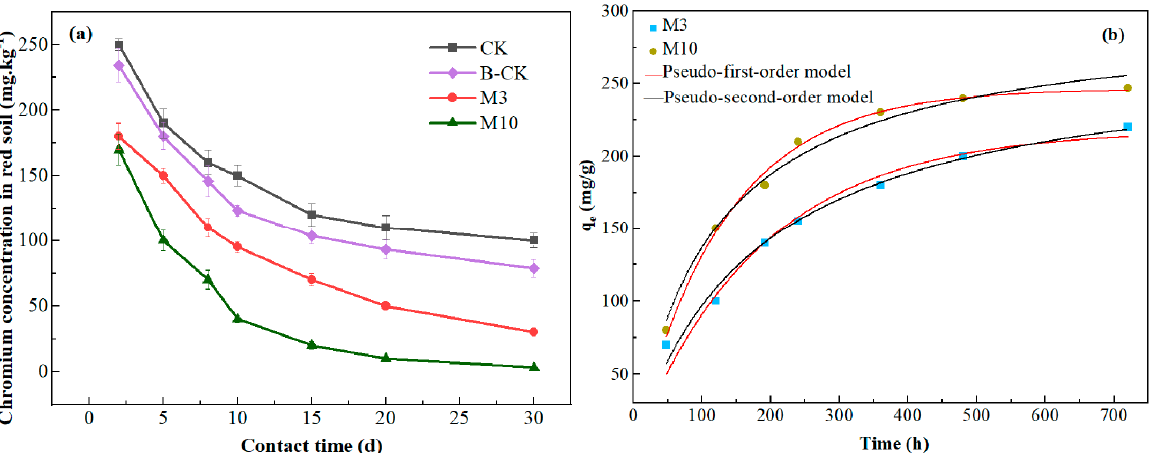
Figure 5. ( a ) Cr 6+ concentration in red soil with increased contact time. CK—control; B-CK—commercial microbial agent. ( b ) Kinetic analysis for Cr 6+ – Aspergillus niger. Table 6. Fitting parameter values of the two kinetic models.